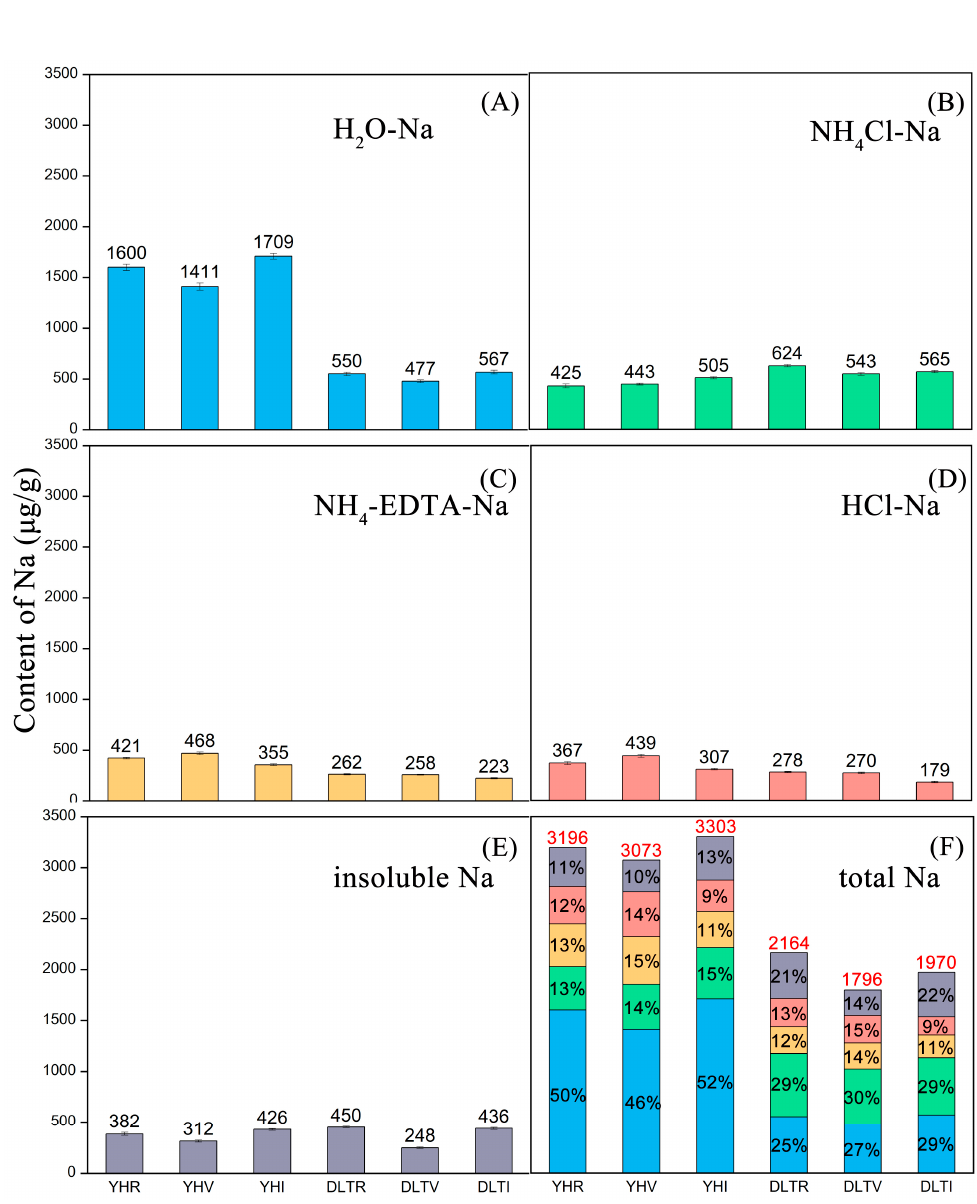
Figure 3. Content distribution characteristics of sodium in samples. ( A ) distribution of H 2 O-Na; ( B ) distribution of NH 4 Cl-Na; ( C ) distribution of NH 4 -EDTA-Na; ( D ) distribution of HCl-Na; ( E ) distribution of insoluble Na; ( F ) distribution of total Na.